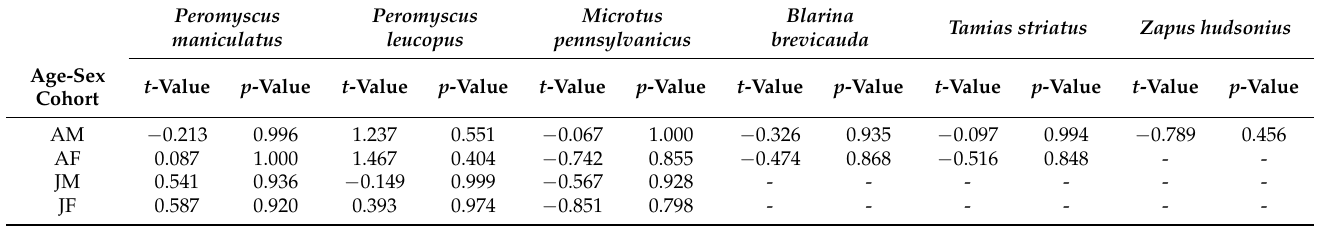
Table 2. Mass model contrast results for each small mammal species captured in both wetland types ( n = 6), for adult males (AM) and females (AF), and juvenile males (JM) and females (JF). Small mammals were captured in West Virginia, USA, in the summers of 2020 and 2021. Species with missing results for categories indicate that no captures were made for that category to compare.